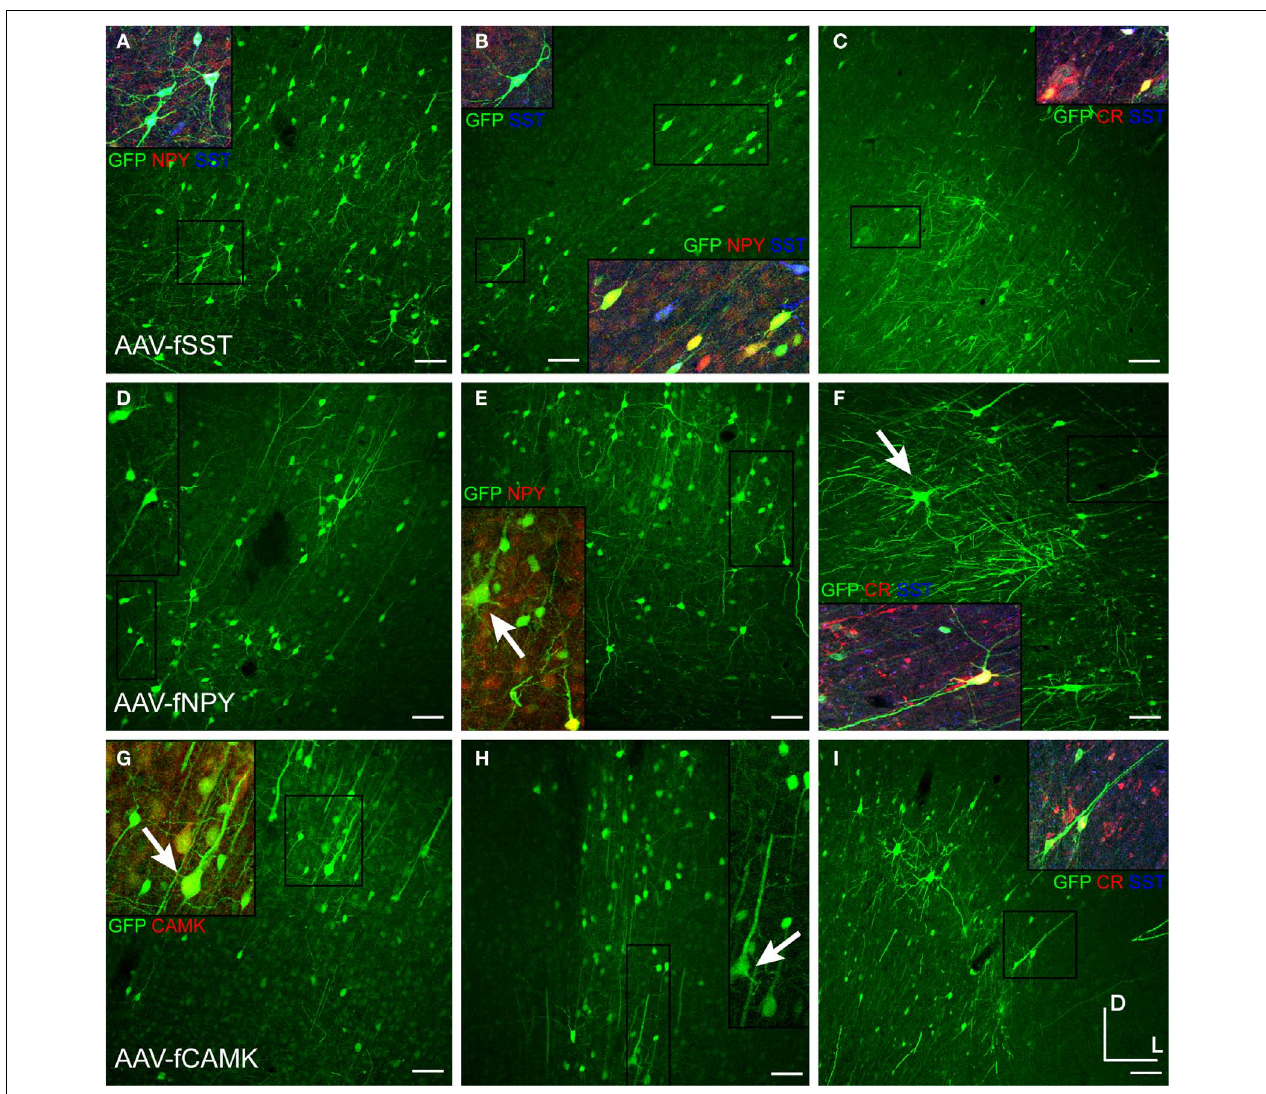
FIGURE 4 | AAV-fSST, AAV-fNPY and AAV-fCAMK expressed in rat and monkey cortex. Viruses expressing GFP were injected in rat somatosensory cortex (A,B,D,E,G,H) and monkey (C,F,I) motor or somatosensory cortex. Molecular identities of some GFP labeled cells of AAV-fSST (A–C) [ (C) – motor cortex], AAV-fNPY (D–F) [ (F) – motor cortex] and AAV-fCAMK (G–I) [ (I) – somatosensory cortex] were determined by co-labeling with NPY,